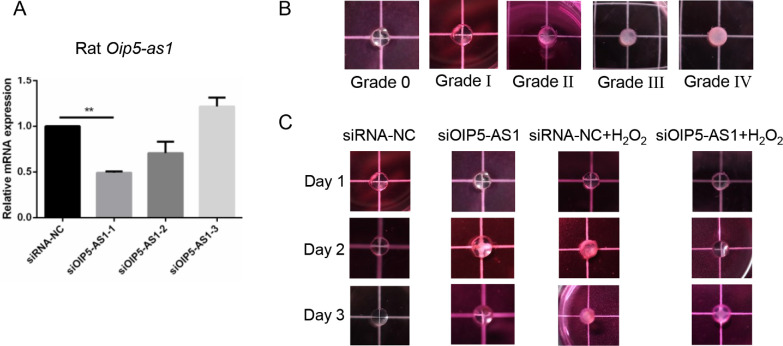

OIP5-AS1 knockdown might be effective in preventing lens opacity ex vivo. (A) OIP5-AS1 knockdown efficiency of siRNA in the rat lens. (B) Grades of isolated lenses on a scale of 0 to 4. (C) The lenses were kept in DMEM and photographed by a Canon M6 system. **P < 0.01.